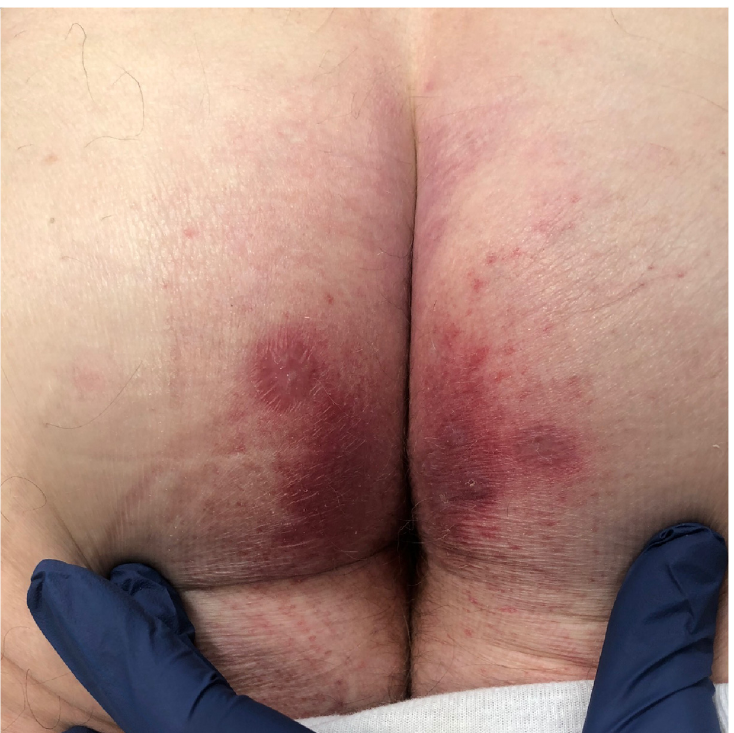
Figure 1. Clinical presentation of dermatitis herpetiformis (DH) on the buttocks: erythematous grouped papules and vesicles.